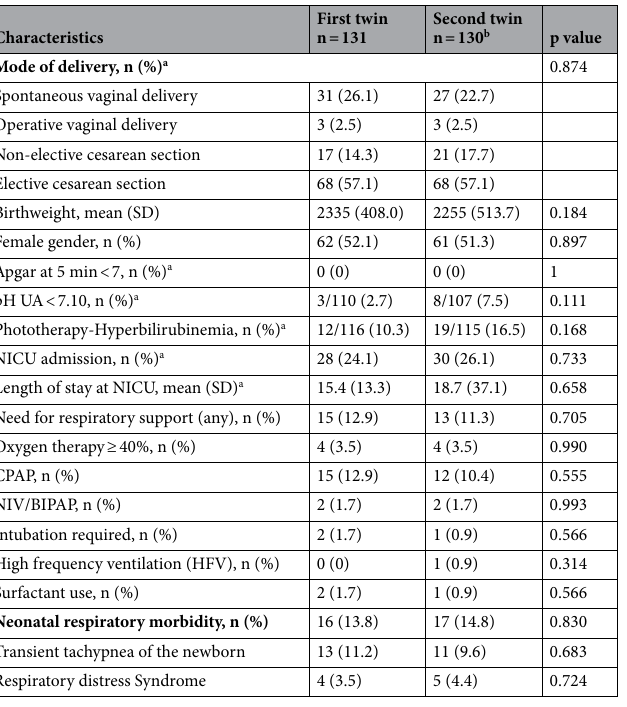
Table 2. Perinatal and neonatal outcomes of the newborns included in the study. Data are presented as mean and standard deviation (SD), percentage (%). UA umbilical artery, NICU neonatal intensive care unit, CPAP continuous positive airway pressure, NIV/BIPAP non-invasive ventilation/Bi-level positive airway pressure. a Variables with missing values. b There was an intrauterine fetal demise in one dichorionic twin pregnancy at 35 weeks of